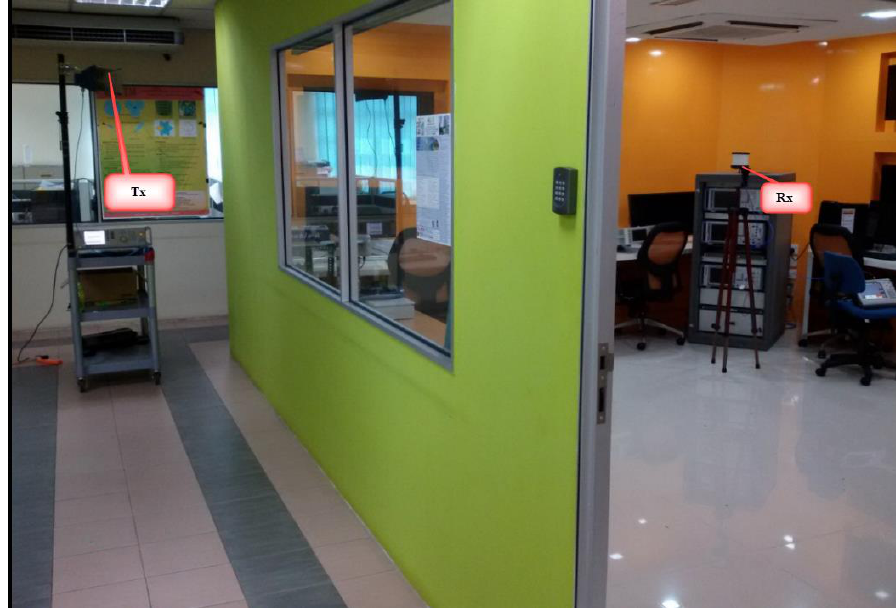
Figure 1. Measurement setup.